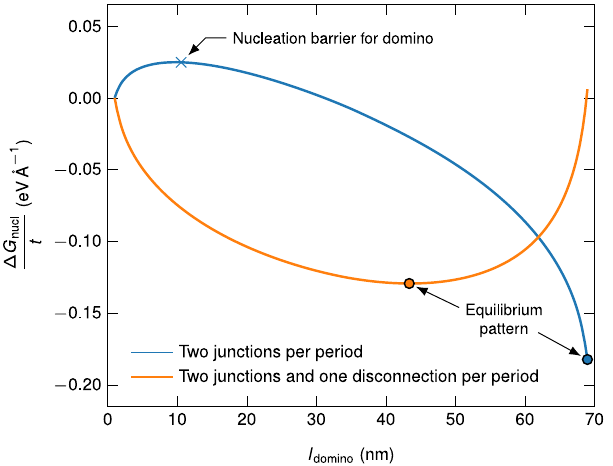
Fig. 9 Schematic for the occurrence of the observed patterning of pearl and domino phase. a – e The domino phase nucleates upon cooling from above the phase transition temperature. The newly formed phase junctions start interacting with pre-existing disconnections, leading to elastic repulsion and prevention of a complete transformation to the domino phase. f Nearly symmetric region from Fig. 2a shown for